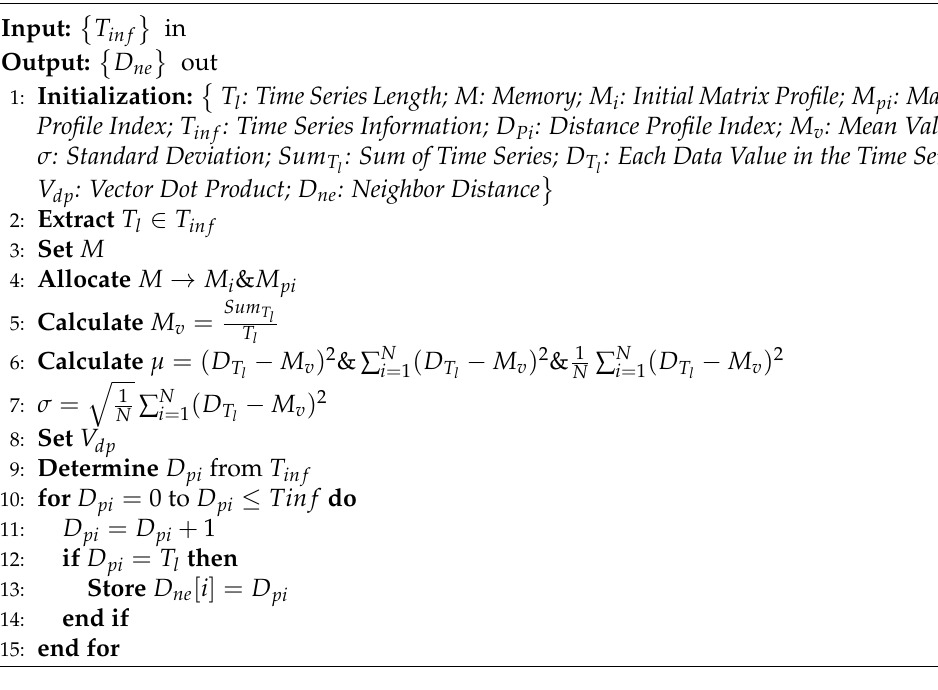
Algorithm 1 Distance Determination